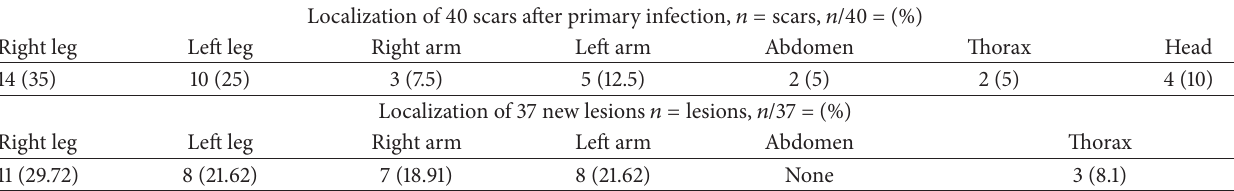
Table 2: Lesions in patients ( 𝑛 = 32 ) with cutaneous leishmaniasis secondary infections. Localization of 40 scars after primary infection, 𝑛 = scars, 𝑛 /40 =